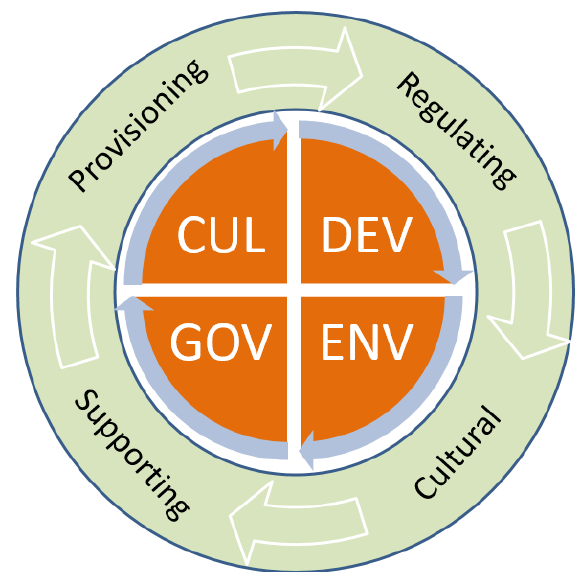
Figure 1. The relationships among the four pillars of Bhutan’s development framework of Gross National Happiness and categories of ecosystem services. The four pillars are: equitable and sustainable socioeconomic development (DEV), cultural preservation and promotion (CUL), environmental conservation (ENV) and good governance (GOV). The four categories of forest ecosystem services are regulating, provisioning, cultural and supporting.